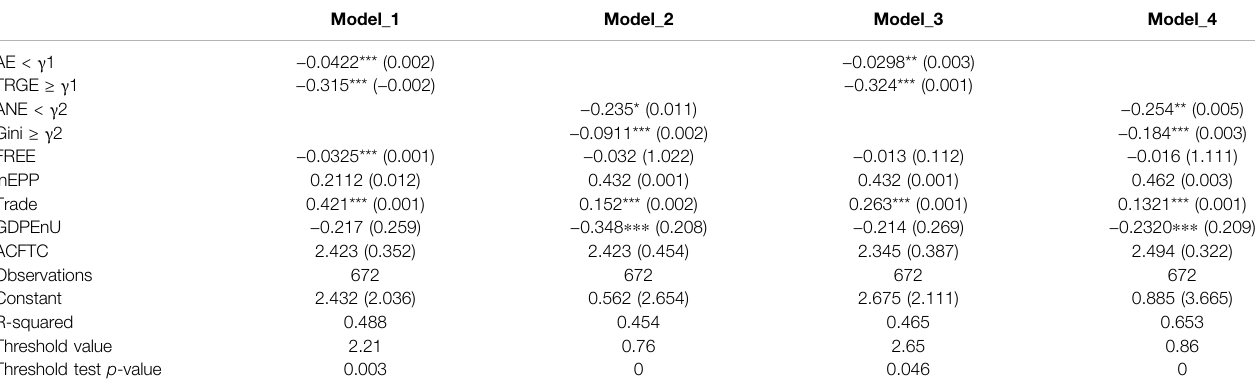
TABLE 1 | Threshold model